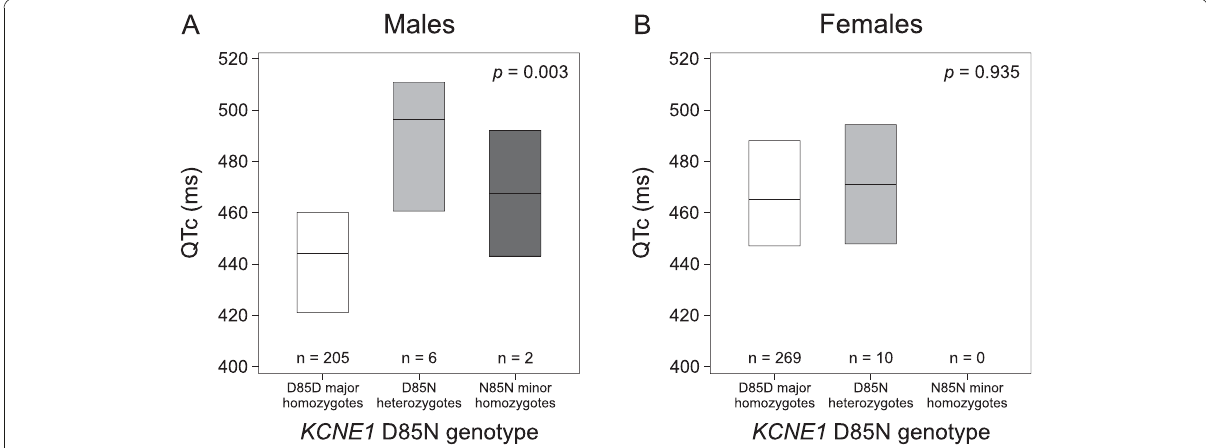
Figure 1 QTc-interval duration in different KCNE1 D85N genotype classes in males and females with KCNQ1 G589D . Box plots show medians and interquartile ranges. The p values in linear regression analyses using additive genotypic model are shown for (A) males and (B) females separately. For interaction between D85N genotype and sex, p = 0.028. QTc, heart rate-corrected